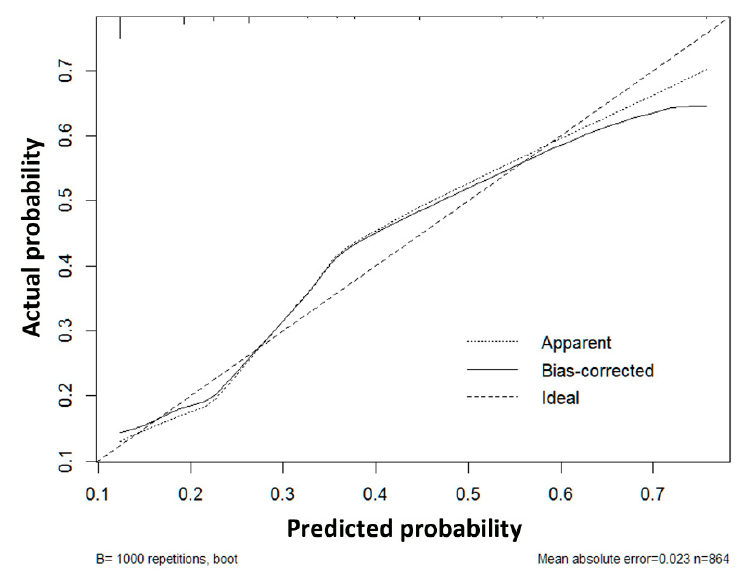
Figure 4. Calibration plot of actual versus predicted probability of microvascular invasion in a training dataset with a mean absolute error of 0.023. Table 4. The comparison of performance measures by using logistic regression mode in MVI probability.